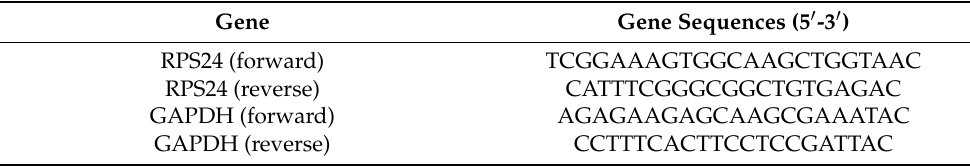
Table 4. The primers of targeted genes of this study. Gene Gene Sequences (5 (cid:48) -3 (cid:48) ) RPS24